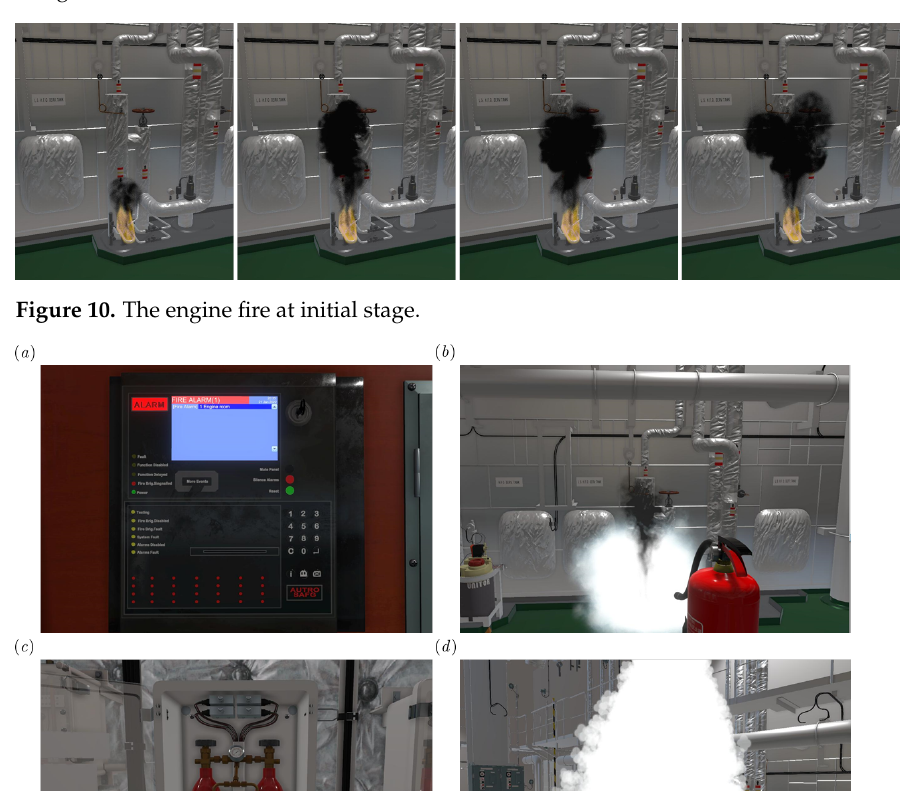
Figure 9. Simulation of a jet using different viscosity coefficient ν of 0.1, 0.05, 0.01, and 0 from left to right.